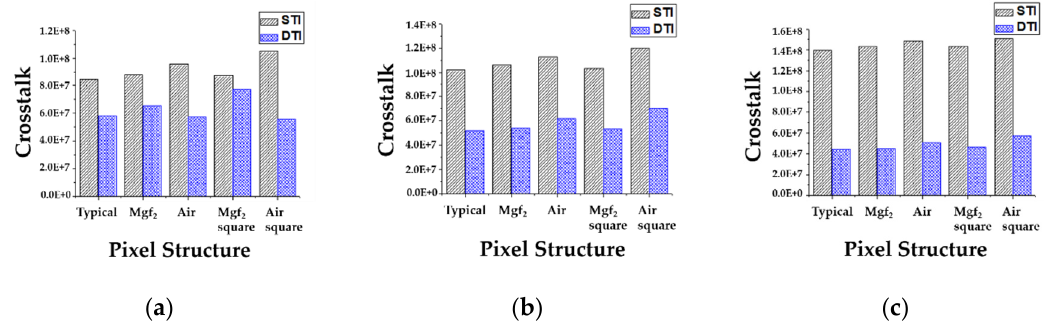
Figure 6. Simulation results of crosstalk at the incident angles of 0 ◦ , 10 ◦ and 20 ◦ . The pixel depths are 1.0 µ m. The crosstalk in the pixels without DTI shows by the black diagonal stripe pattern, and the crosstalk with DTI shows by the blue check pattern. The pixels without the front-inner lens and with the front-inner lens of MgF2, MgF2 square type, air, and air square type are compared. ( a ) Crosstalk at the incident angles of 0 ◦ , ( b ) crosstalk at the incident angles of 10 ◦ , ( c ) crosstalk at the incident angles of 20 ◦ .